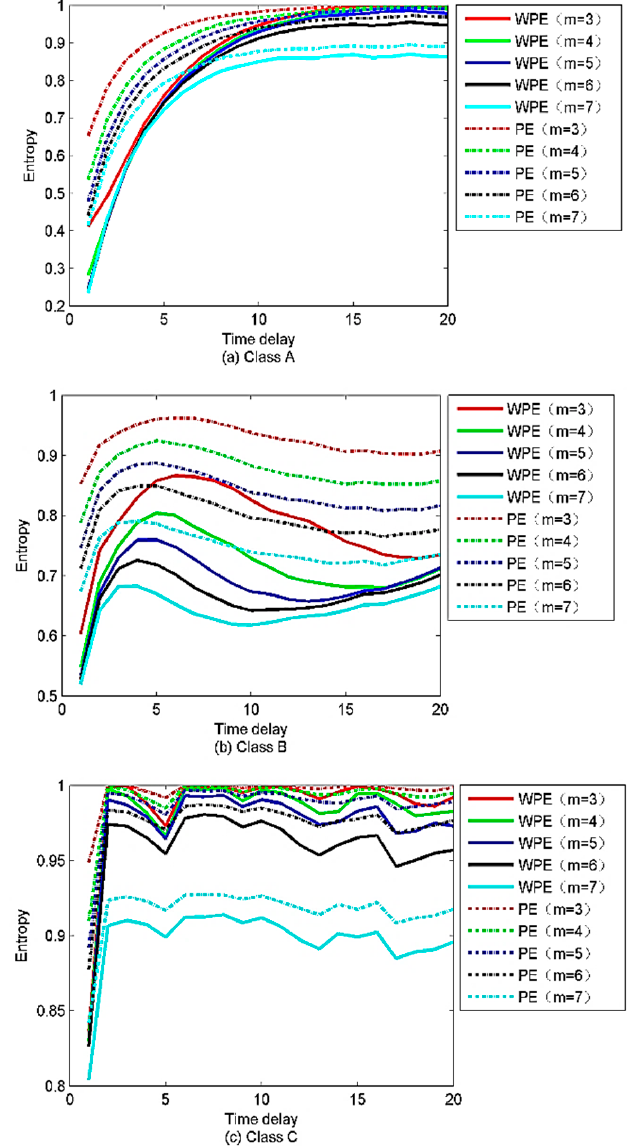
Figure 11. PE and WPE of the signals varying with the time delay; ( a ) Class A signal; ( b ) Class B signal; ( c ) Class C signal.